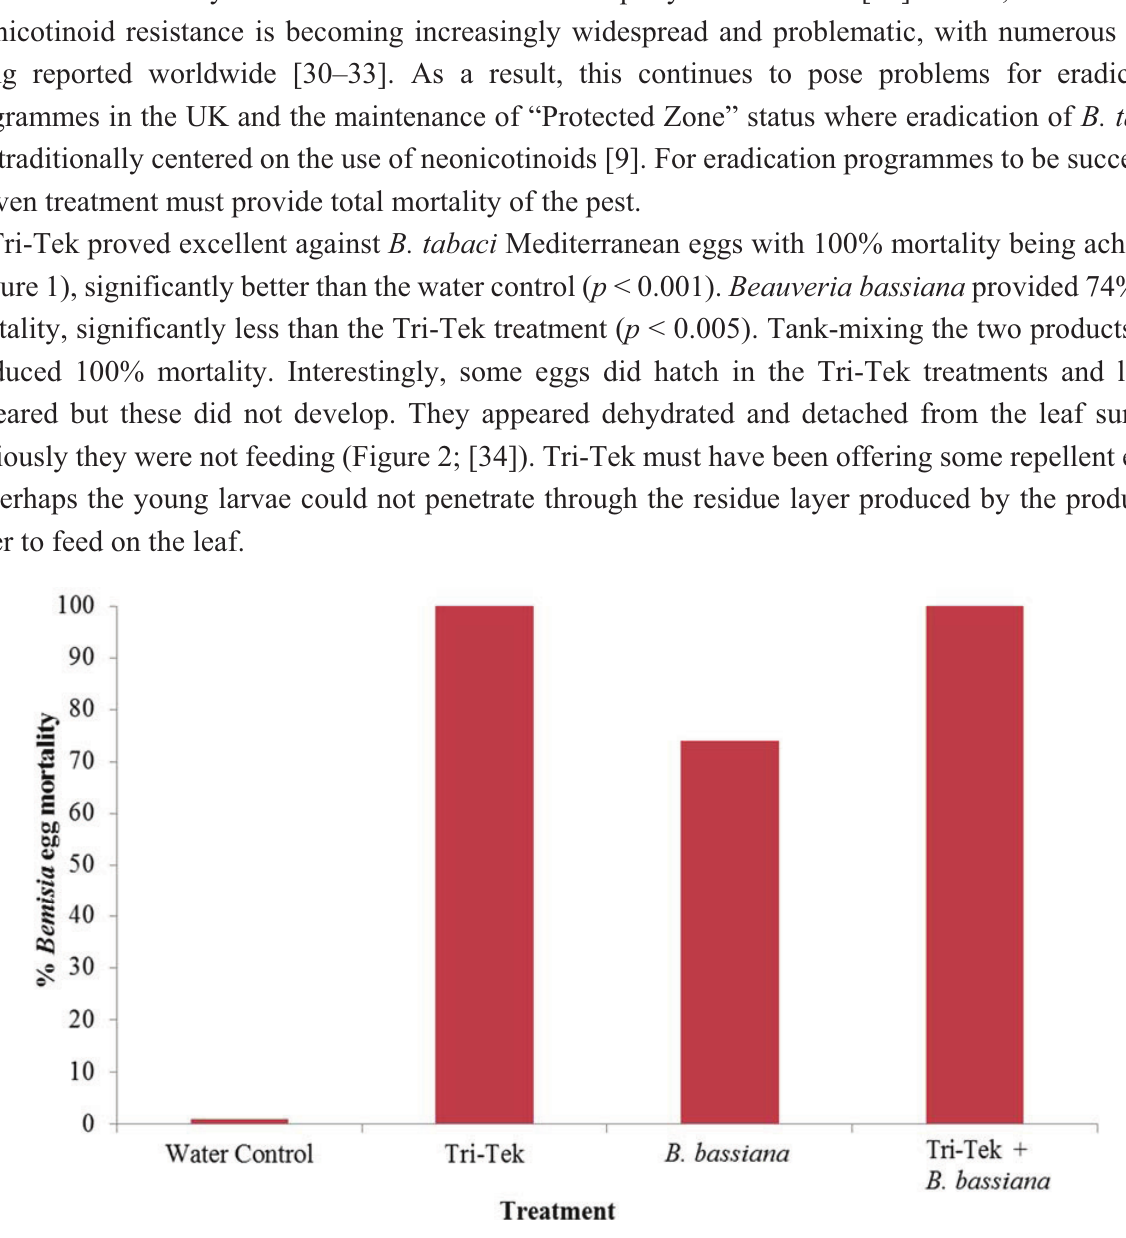
Figure 1. Efficacy of Tri-Tek and Beauveria bassiana and a tank-mix of both products against Bemisia tabaci Mediterranean eggs under glasshouse conditions. Mortality assessed following seven days after